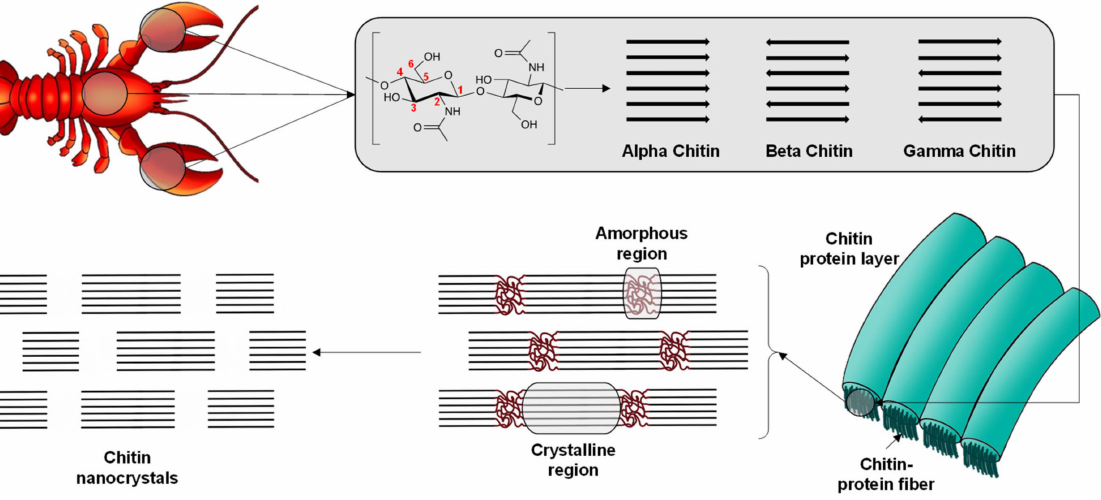
Figure 1. Schematic illustrations for chitin structures and polymorphs, and for the preparation process of chitin